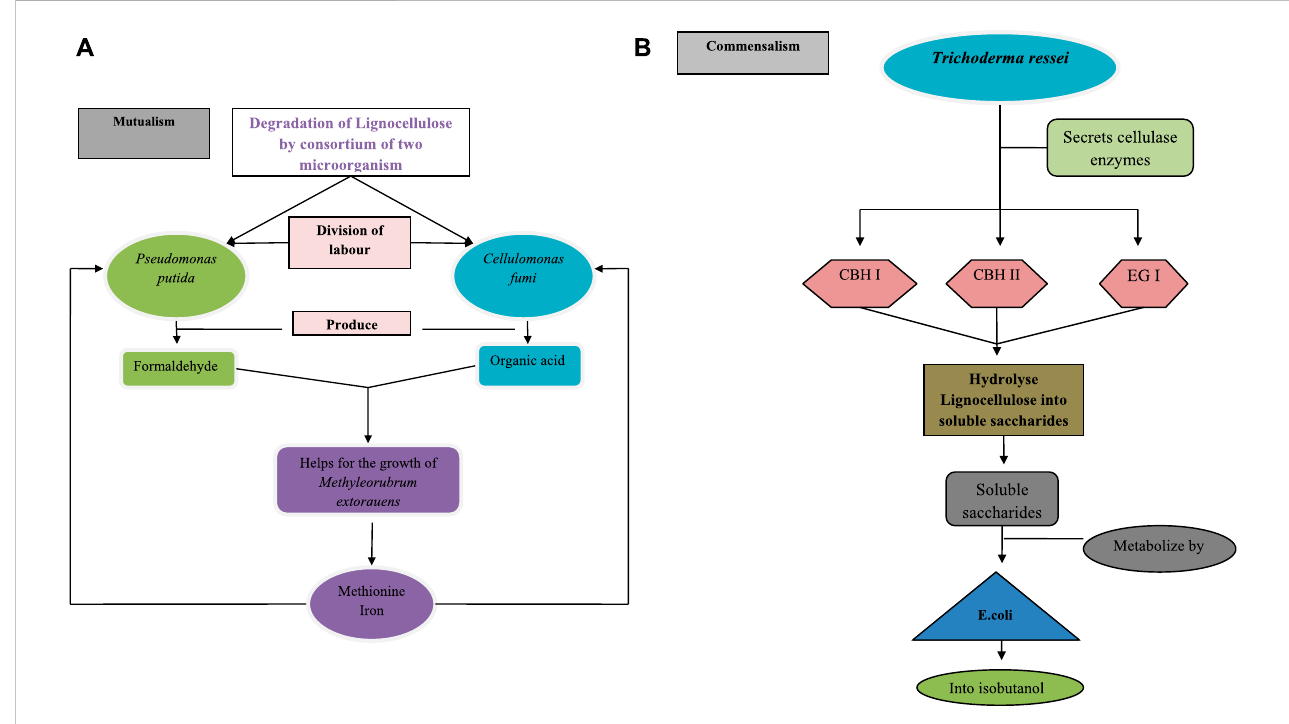
FIGURE 6 Lignocellulosedegradationby (A) consortiumof Pseudomonasputida andcellulomonasfungibytheirmutualisminteraction,divisionoflabourbetween boththemicroorganismispresentforthedegradationoflignocelluloseafterthedegradation Pseudomonasputida produceformaldehydeand Cellulomonas fumi produceorganicacids,thathelpsinthegrowthof MethylRubrumextorquens whichinturnsecretesmethionineandironforthegrowthof Pseudomonas putida and Cellulomonas fumi (B) consortium of Trichoderma reesei and Escherichia coli by their commensalism interaction, in this interaction, Trichoderma ressei secretes cellobiohydrolaseI (CBH I), cellobiohydrolase II (CBH II) and endoglucanase (EG I) cellulase enzymes to hydrolyse lignocellulose into soluble saccharides and these soluble saccharides metabolize by E. coli into